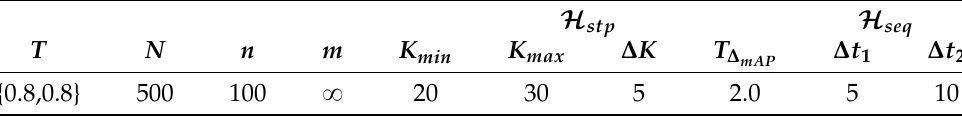
runs in r 0..100 s . T hyper-parameter contains the mAP H H stp seq ∆ t ∆ t 2 1 mAP